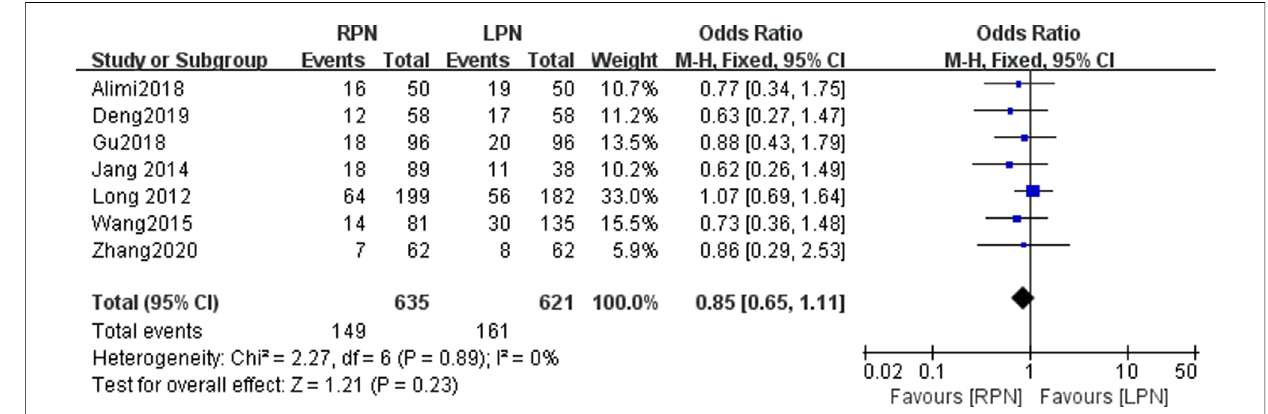
FIGURE 9 Forest plot for postoperative complications between the RPN and LPN.